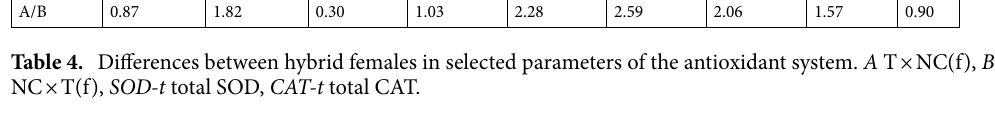
DPPH SOD-t SOD1 SOD2